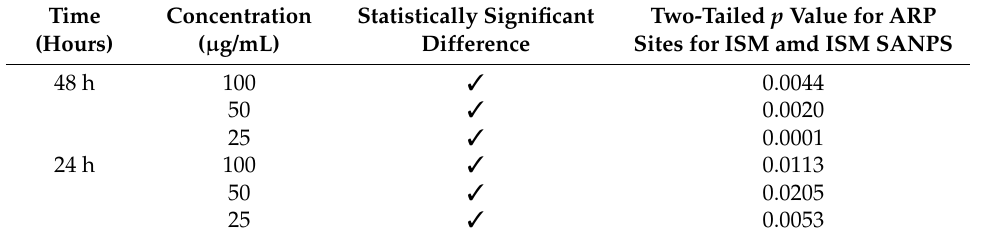
Table 1. The difference between ARP sites of ISM amd ISM SANPS